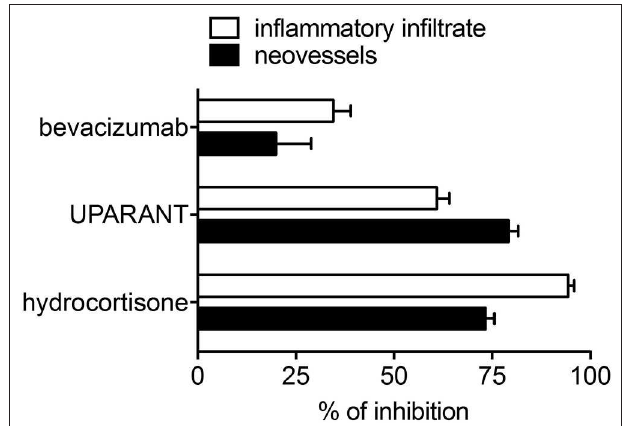
FIGURE 5 | Inhibition of the angiogenic/inflammatory response induced by PDR vitreous in the chick embryo CAM. Chick embryo CAMs were treated with PDR vitreous in the absence or in the presence of different inhibitors. Note the more potent inhibitory effect exerted by the anti-inflammatory